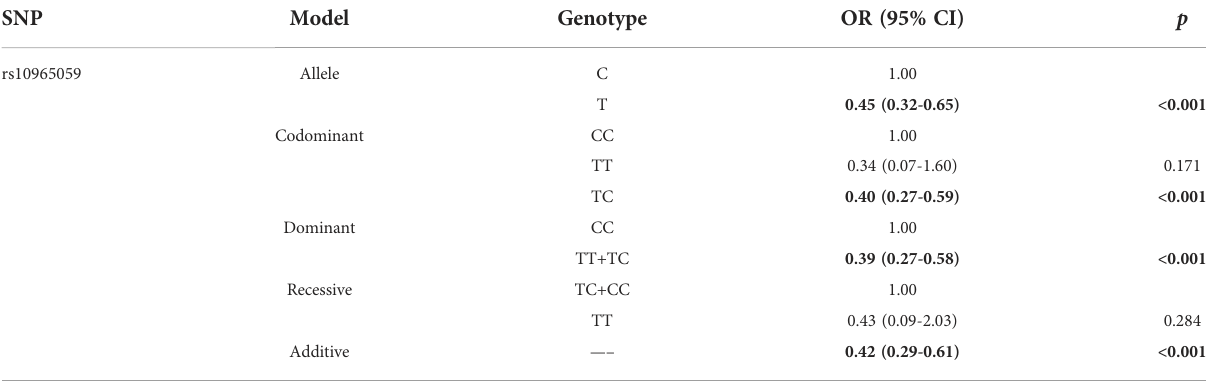
TABLE 5 Association between MIR31HG polymorphisms and ONFH risk strati fi ed by necrotic sites. SNP Model Genotype